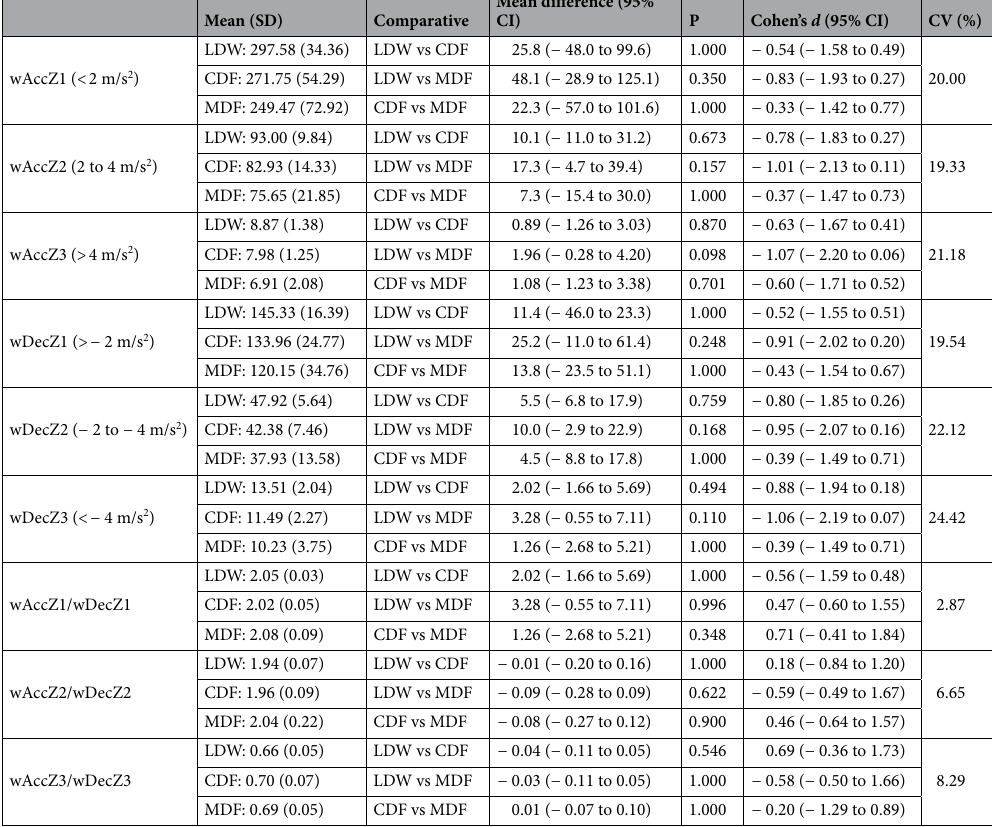
Table 2. Between-group differences for derived-GPS variables of acceleration and deceleration in the full season. Notes: wAccZ1, weekly average of accelerations in zone 1 (< 2 m/s 2 ) as number; wAccZ2, weekly average of accelerations in zone 2 (2 to 4 m/s 2 ) as number; wAccZ3, weekly average of accelerations in zone 3 (< 4 m/s 2 ) as number; wDecZ1, weekly average of decelerations in zone 1 (< − 2 m/s 2 ) as number; wDecZ2, weekly average of decelerations in zone 2 (− 2 to − 4 m/s 2 ) as number; wDecZ3, weekly average of decelerations in zone 3 (< − 4 m/s 2 ) as number; wAccZ1/wDecZ1, ratio between weekly accelerations and decelerations in zone 1; wAccZ2/wDecZ2, ratio between weekly accelerations and decelerations in zone 2; wAccZ3/wDecZ3, ratio between weekly accelerations and decelerations in zone 3; LDW, lateral defenders and wingers; CDF, central defenders and forwards; and MDF, midfielders; P, P-value at alpha level 0.05; Cohen’s d (95% CI), Cohen’s d effect size magnitude with 95% confidence interval; CV, coefficient of variations for overall team as